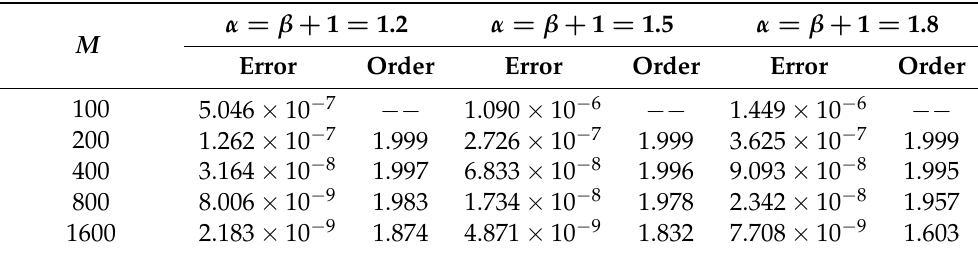
Table 1. The L 2 -errors and the convergence order of φ versus M and α = β + 1 with N = 100 for example 1.